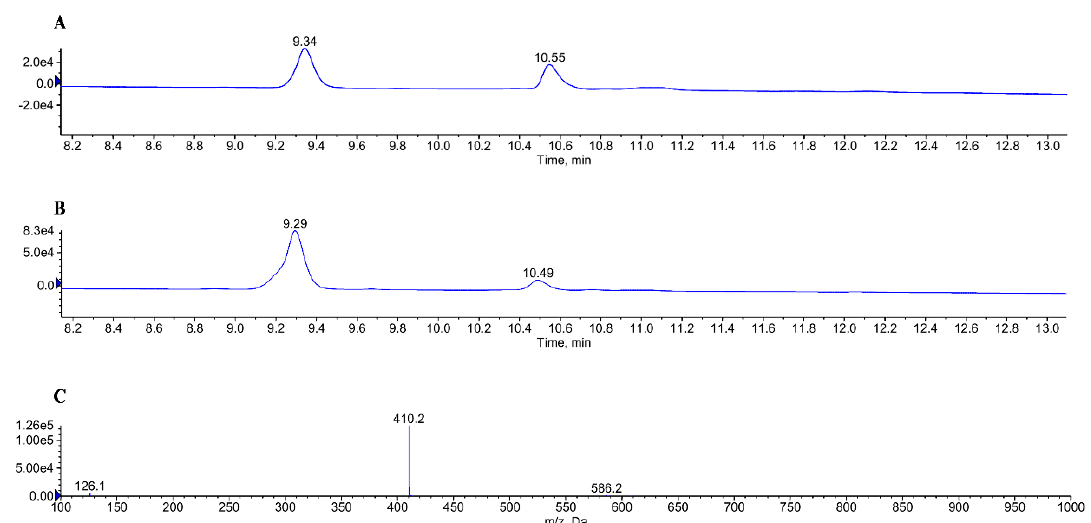
Figure 3. HPLC-UV-TripleTOF analysis of chemically synthesized and biosynthesized 5- O -glucuronide GL-V9 in rat plasma: ( A ) UV channel chromatogram of rat plasma, the peak area of 5- O -glucuronide GL-V9 was 2.3215 × 10 5 ; ( B ) UV channel chromatograph of rat plasma with chemically synthesized 5- O -glucuronide GL-V9 standard solution, the peak area of 5- O -glucuronide GL-V9 was 6.5219 × 10 5 ; ( C ) TripleTOF Mass spectrum for 5- O -glucuronide GL-V9).